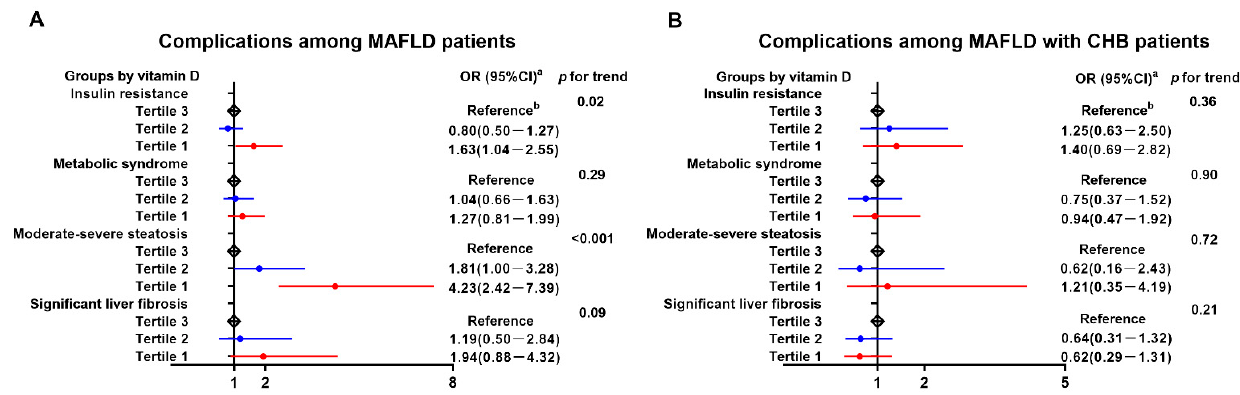
Figure 2. Dose-dependent relationships between VitD tertiles and complications in MAFLD patients without ( A ) or with ( B ) CHB. CHB, chronic hepatitis B; MAFLD, metabolic-associated fatty liver disease; VitD, vitamin D. Insulin resistance is defined as homeostasis model assessment of insulin resistance >2.5. Metabolic syndrome is defined as meeting at least three of the following criteria: (a) waist circumference ≥ 90 cm (men) and ≥ 80 cm (women); (b) blood pressure ≥ 130/85 mmHg or use of hypertensive medication; (c) reduced high-density lipoprotein cholesterol level (<1.03 mmol/L for males, <1.3 mmol/L for females); (d) elevated triglyceride level ( ≥ 1.7 mmol/L); and (e) elevated fasting plasma glucose ( ≥ 5.6 mmol/L) or drug treatment for hyperglycemia. Significant fibrosis is defined as liver stiffness measurements >7.1 kPa. Moderate–severe steatosis is defined as liver fatty content ≥ 16.3%.